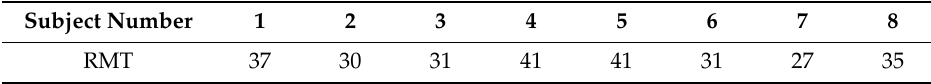
Table A1. The resting motor threshold (RMT) values for the healthy volunteers, in percent of the maximum stimulator output. The values were determined in the first mapping session (and the intensity kept at 110% of this value in all three